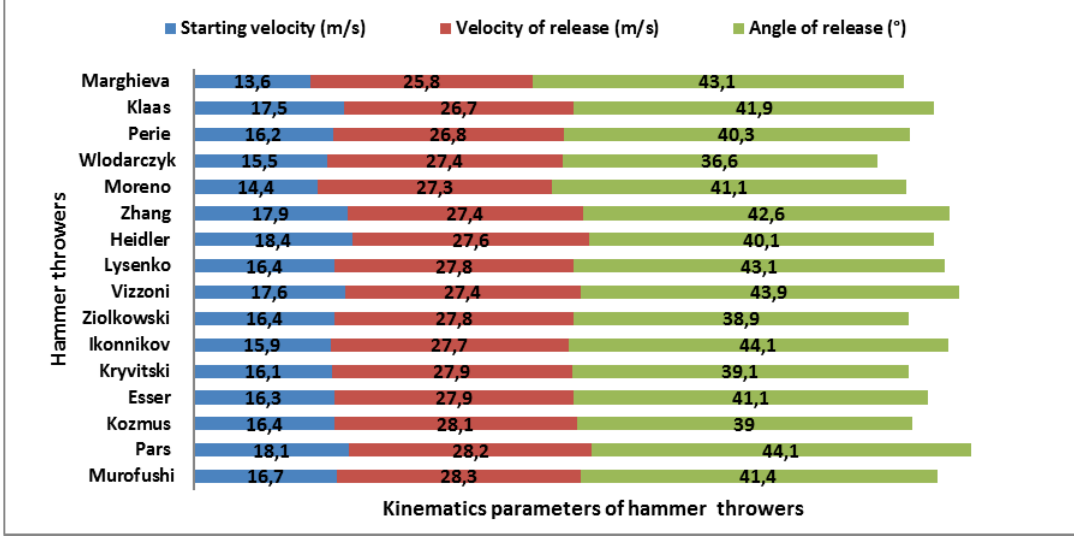
Figure 3. Distribution of individual results